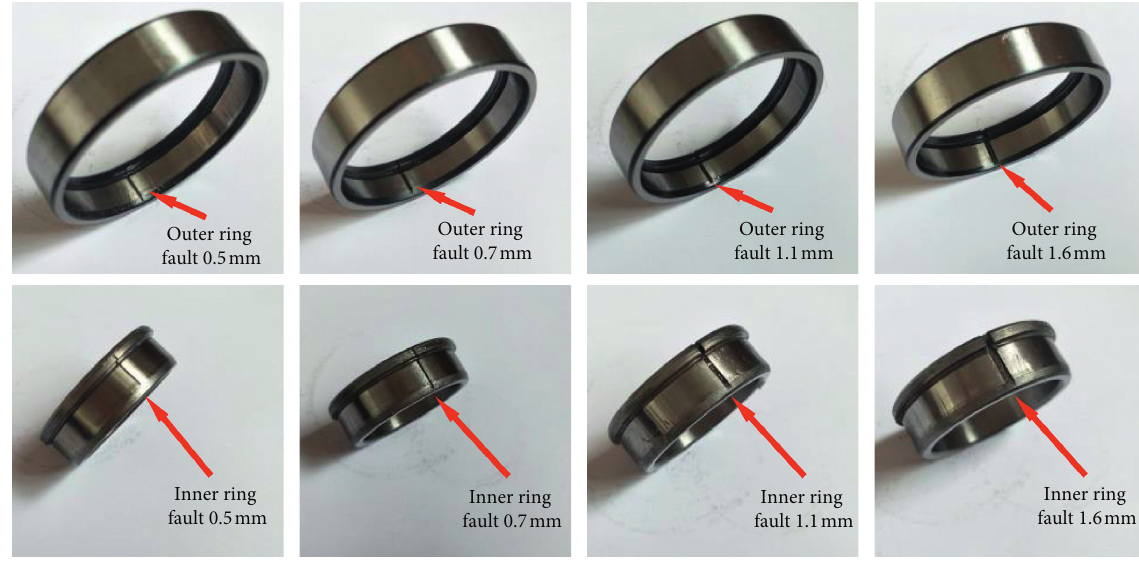
Figure 8: Tested fault bearings.